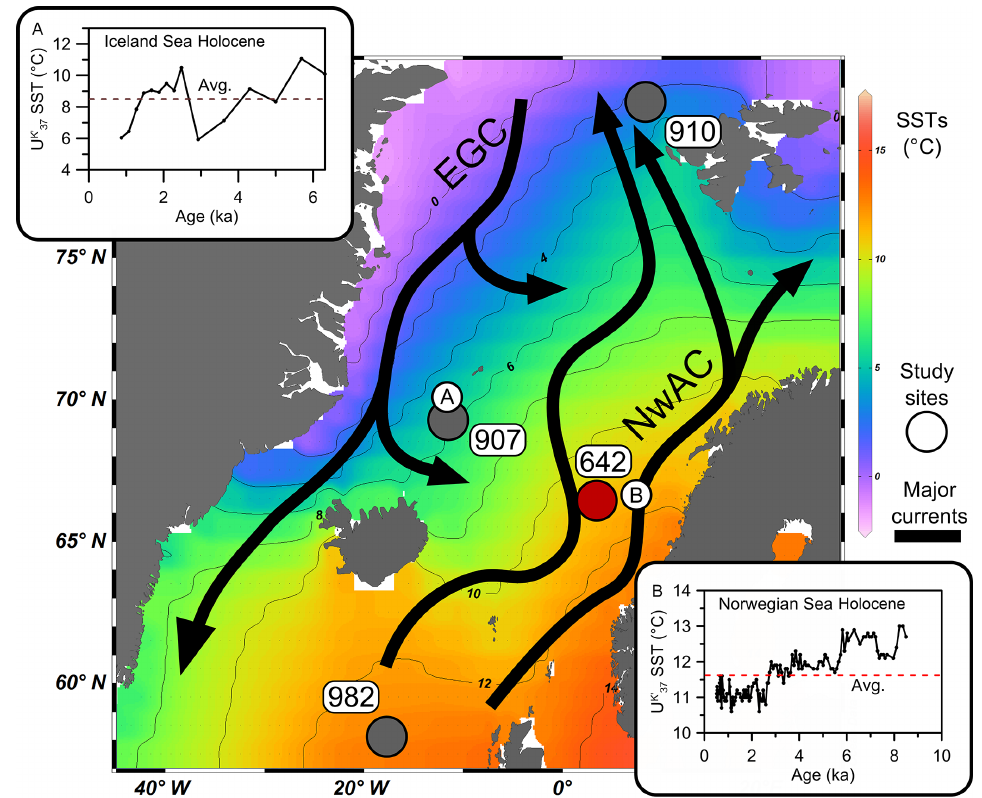
Figure 1. Nordic Seas, showing simplified modern surface currents and summer temperatures (JAS, World Ocean Atlas). NwAC: Norwegian Atlantic Current; EGC: East Greenland Current. The study site, ODP Hole 642B, is marked by a red circle. Pliocene sites referred to in the text (ODP Sites 907, 910 and 982) are marked by grey circles. The two sites that provide Holocene SST averages for comparison are marked with small white circles. Holocene SST data are shown in inserts (A: GS15-198-62 MC-A, this study, Table 1; B: MD95-2011, Calvo et al., 2002), with dashed lines indicating